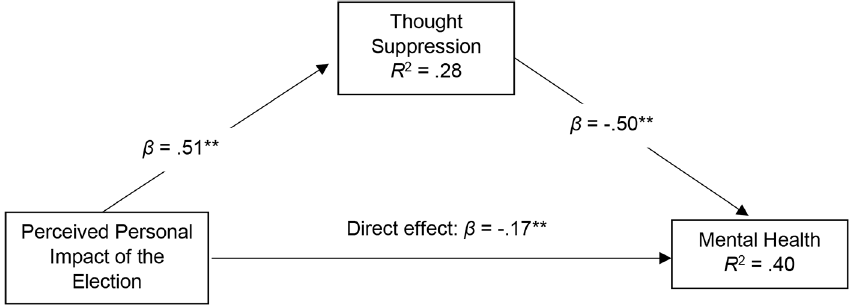
Figure 2. Perceived Personal Impact of the Election predicting Mental Health Note. Covariates = Age, Sexual Orientation; n = 298; ** p < .01. Total effect: β = -.42, p <